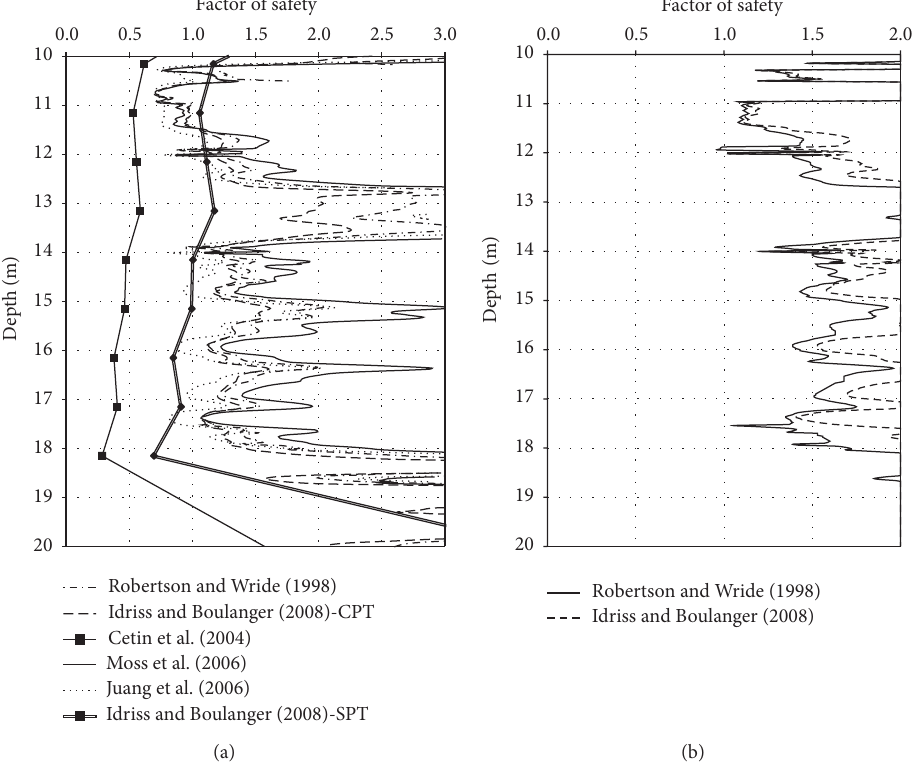
Figure 4: Factor of safeties against liquefaction computed by different SPT and CPT based methods (a) and by CPT based method of Idriss and Boulanger using different empirical correlations to determine fines content